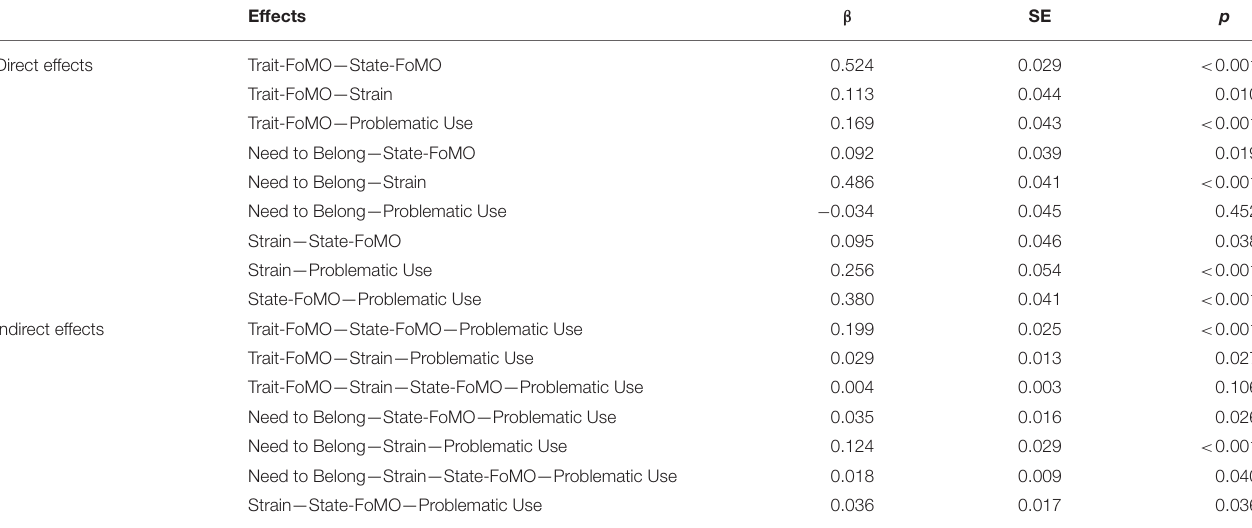
TABLE 4 | Overview of the standardized coefficients illustrating the direct and indirect effects in the